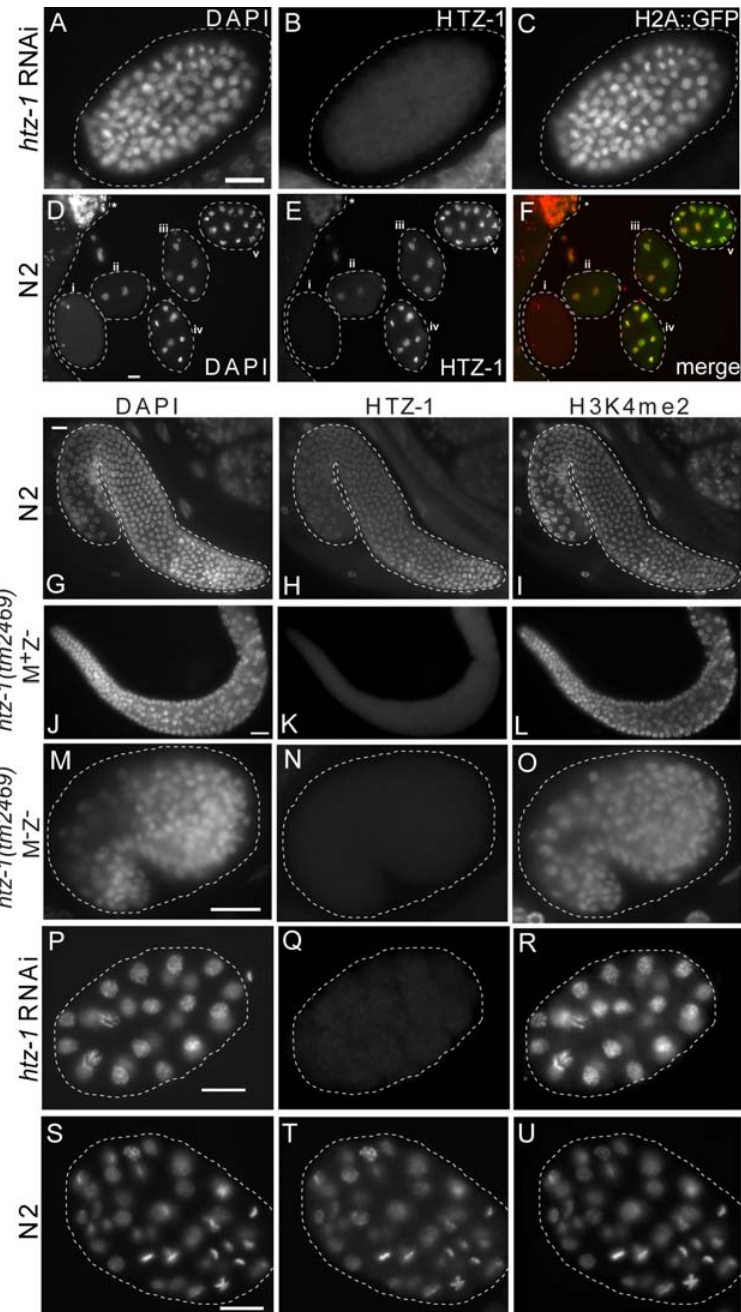
Figure 2. Immunofluorescence of htz-1(tm2469) and htz-1 RNAi treated animals. H2A::GFP embryo treated with htz-1 RNAi and stained with (A) DAPI, (B) anti-HTZ-1, and (C) anti-GFP. Immunofluorescence of early N2 embryo progression (D) DAPI, (E) anti-HTZ-1, and (F) merged DAPI (red) and HTZ-1 (green). In panels D-F: (i) fertilized egg, (ii) 2-cell embryo, (iii) 4-cell embryo, (iv) 8-cell embryo, (v) 16-cell embryo. Asterisk (*) indicates nearby germline cells. (G–U) Samples were stained with DAPI (column 1), anti-HTZ-1 (column 2) and anti-histone H3 dimethyl lysine 4 (column 3). In all images, anti-H3k4me2 serves as a positive control for antibody staining. (G–I) N2 gonad, (J–L) htz-1(tm2469) M + Z 2 gonad, (M–O) htz-1(tm2469) M 2 Z 2 embryo, (P–R) htz-1 RNAi, and (S–U) N2 embryo. White scale bars indicate 10 m